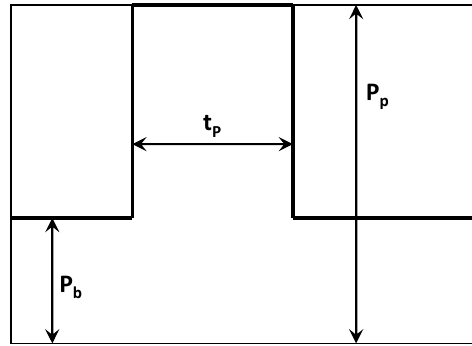
Figure 3. User duty load profile during weekdays.